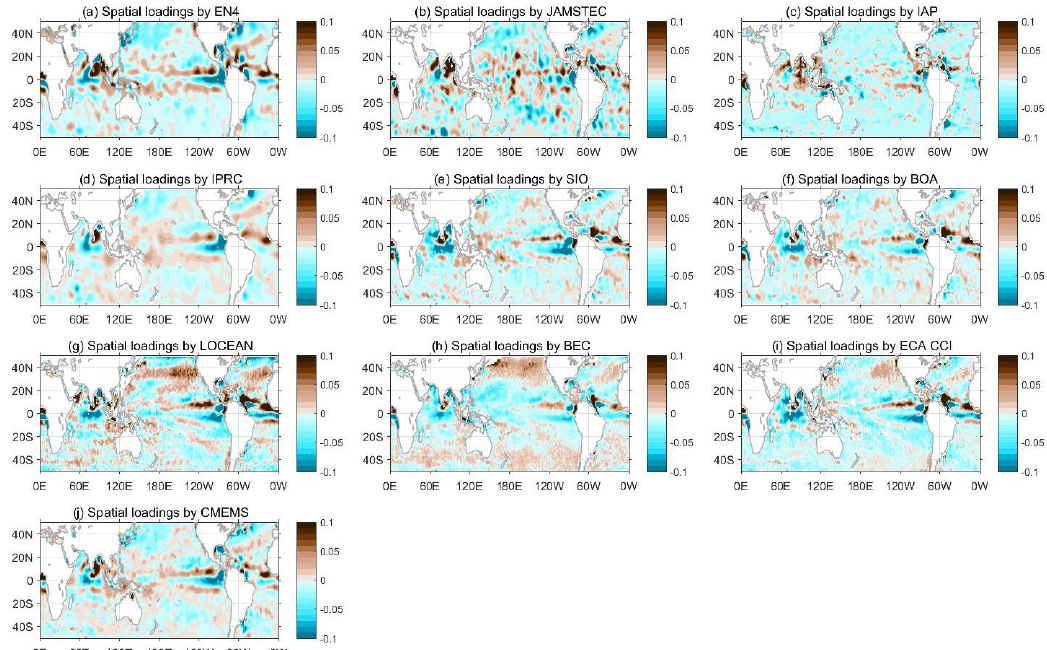
Figure 7. The spatial loadings of the first EOF modes for the sub-annual SSS derived from an individual product.